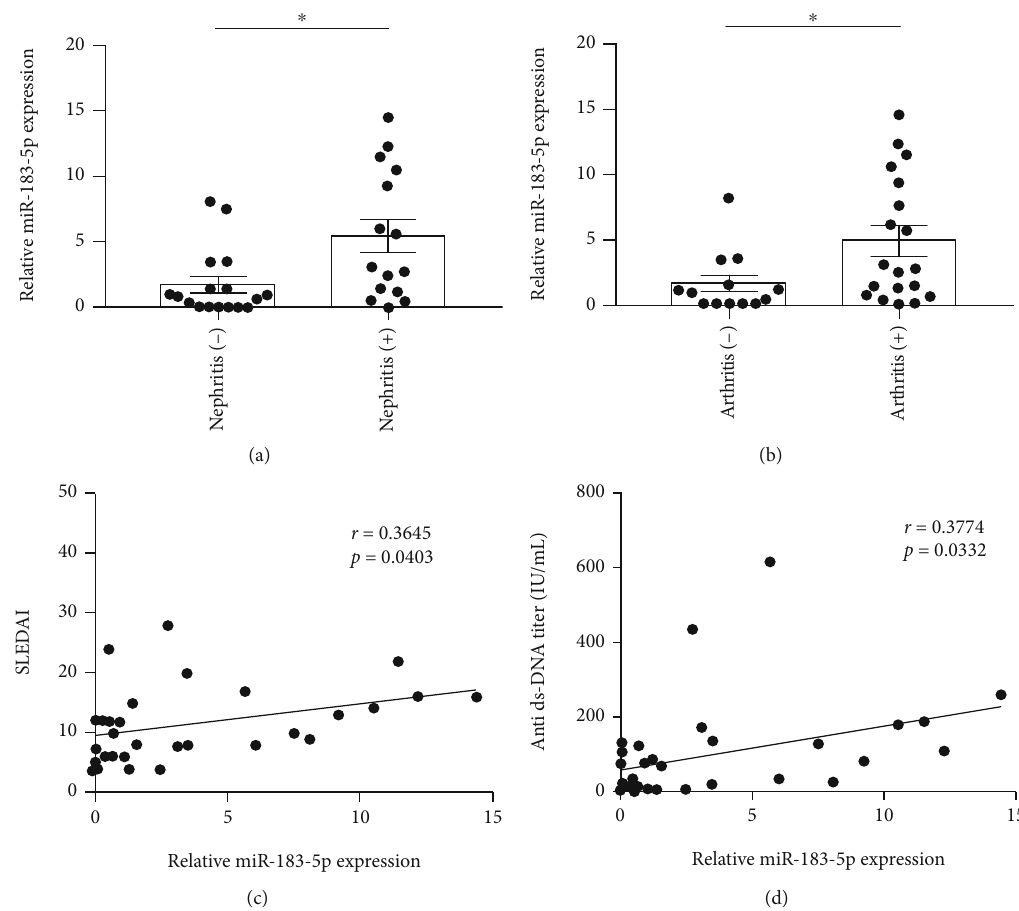
Figure 6: miR-183-5p is associated with patient data in SLE. The expression level of miR-183-5p was higher in SLE cases with nephritis (a) or arthritis (b) in comparison with negative SLE counterparts, showing signi fi cant positive associations with SLEDAI score (c) or anti-dsDNA antibody levels (d). ∗ p < 0 : 05